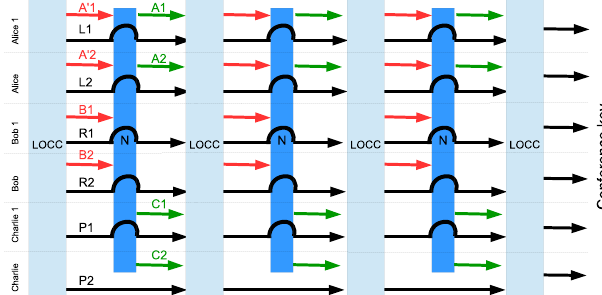
FIG. 3. Example of an LOCC-assisted secret-key-agreement protocol among six parties — Alice 1, Alice 2, Bob 1, Bob 2, Charlie 1, and Charlie 2 — using the multiplex channel N three times. Inputs into N are depicted in red, outputs in green, and reference systems in black. Alice 1 and 2 enter systems into and receive systems from N , Bob 1 and 2 only enter systems, and Charlie 1 and 2 only receive systems. In the end, the six parties obtain a six-partite conference